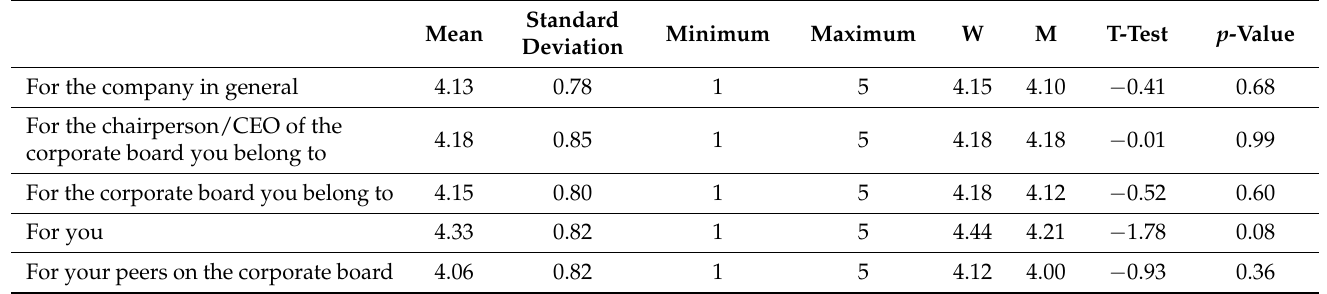
Table A6. Descriptive statistics and mean comparison between women and men who responded to P19—Please indicate, on a scale from 1 = Not Important to 5 = Very Important, to what extent you consider equality between women and men is important.